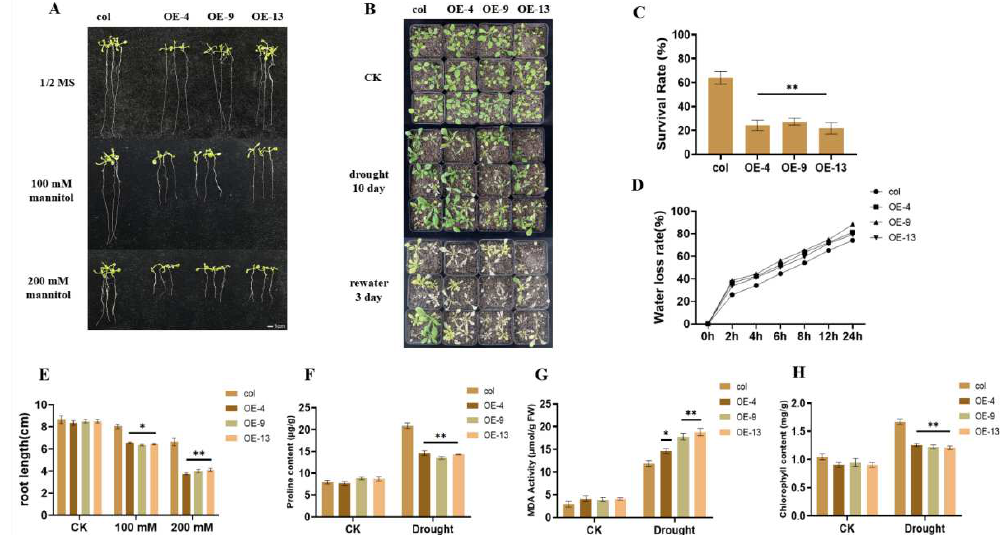
Figure 4. Drought resistance of wild-type and ZmGST26 -overexpressing Arabidopsis plants. ( A , E ) Roots length in transgenic and wild-type Arabidopsis treated with mannitol. ( B ) Phenotypes of transgenic and wild-type Arabidopsis plants under drought conditions. ( C ) Survival rates of ZmGST26 - overexpressing transgenic plants and wild-type Arabidopsis plants after re-watering. ( D ) Water loss rate. ( F ) Proline content. ( G ) MDA content. ( H ) Chlorophyll content. * p < 0.05; ** p < 0.01. All bars represent means ± SD, (n ≥